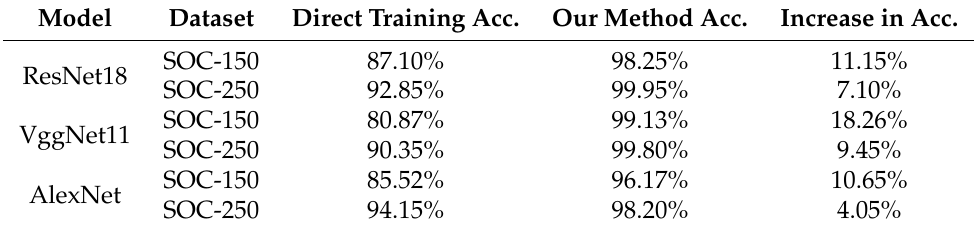
Table 11. Experimental results under different CNN